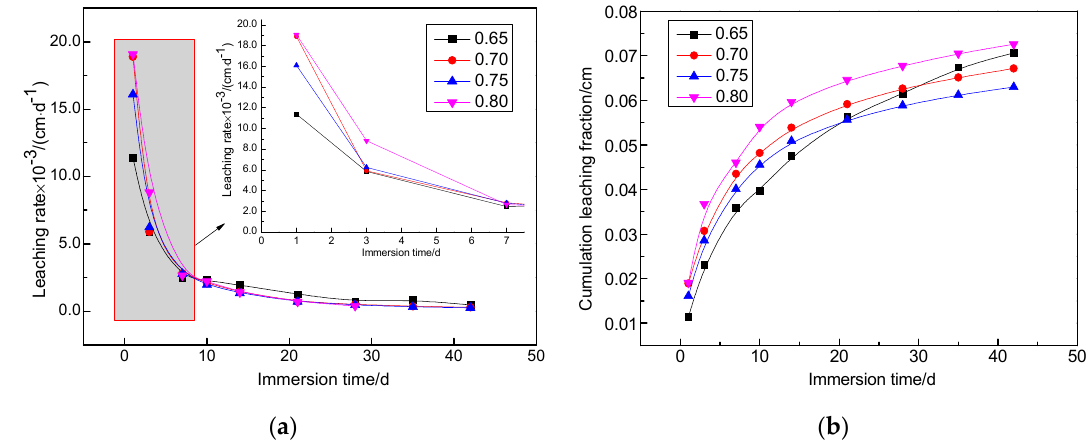
Figure 4. Leaching rate and cumulative fraction leached curves of different water–cement ratios for the MgO–SiO 2 –H 2 O solidified bodies with 1.6 wt.% Sr 2+ under leaching conditions at an ambient temperature of 25 °C and using deionized water as leachant. (a) Leaching rate curves(b) Cumulative